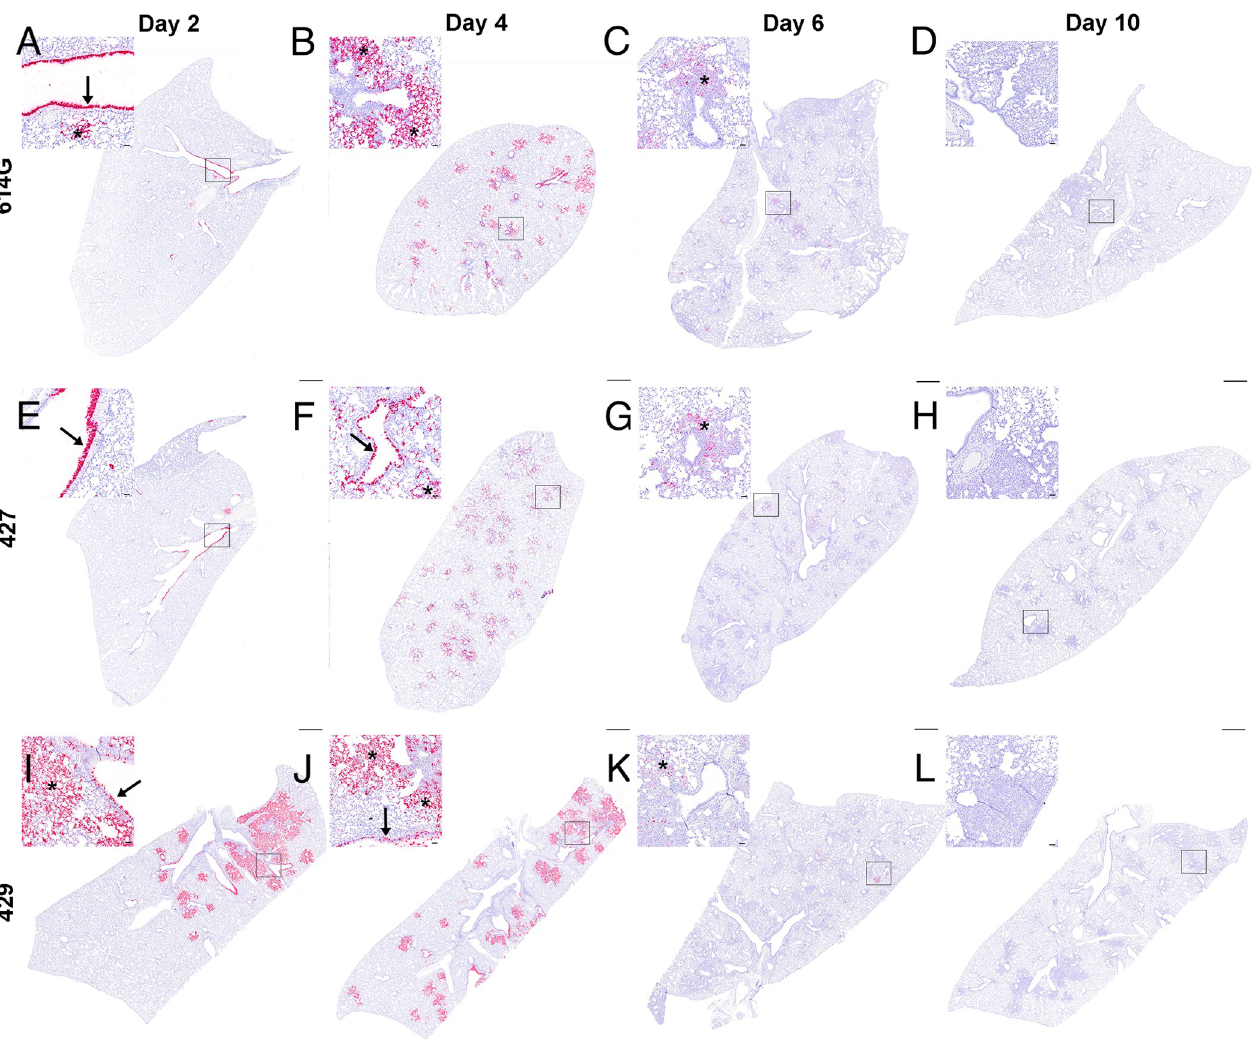
Fig 4. Distribution of SARS-CoV-2 RNA+ cells in lungs of hamsters after intranasal inoculation with B.1 (614G), B.1.427 and B.1.429 by in-situ hybridization (ISH). Sub-gross histology and magnified regions (inset) of ISH-labeled lung sections from hamsters infected with B.1 (614G) for A) 2 days PI, B) 4 days PI, C) 6 days PI and D) 10 days PI; or B.1.427 for E) 2 days PI, F) 4 days PI, G) 6 days PI and H) 10 days PI; or B.1.429 for I) 2 days PI, J) 4 days PI, K) 6 days PI and L) 10 days PI. Cells labeled by riboprobe in-situ hybridization stain red. Arrows = labeled bronchial/bronchiolar epithelial cells lining airways; asterisks = regions of lung parenchyma with labeled alveolar septal cells (type I/II pneumocytes and macrophages). Original magnification: 1x. Scale bars equal 1 mm. Inset scale bars equal 50 um.